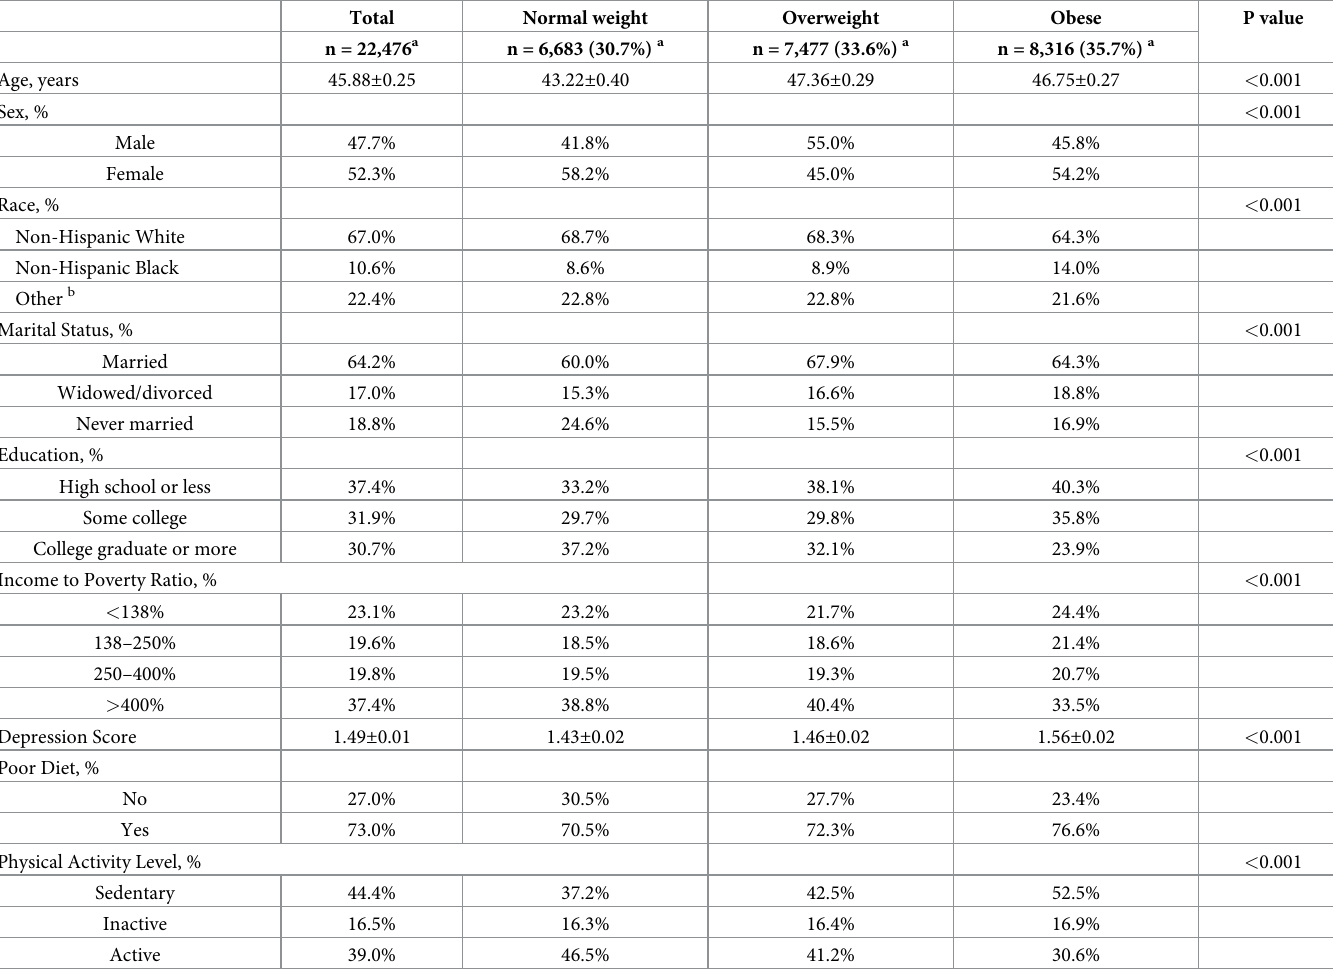
Table 1. Characteristics of U.S adults age 30–65 years old with no history of cardiovascular disease (population-weighted, NHANES